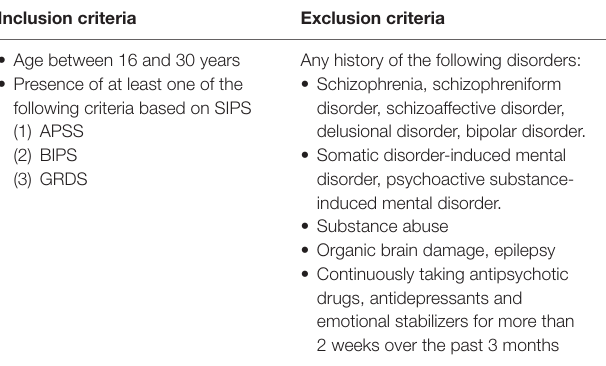
TaBle 1 | Inclusion and exclusion criteria for